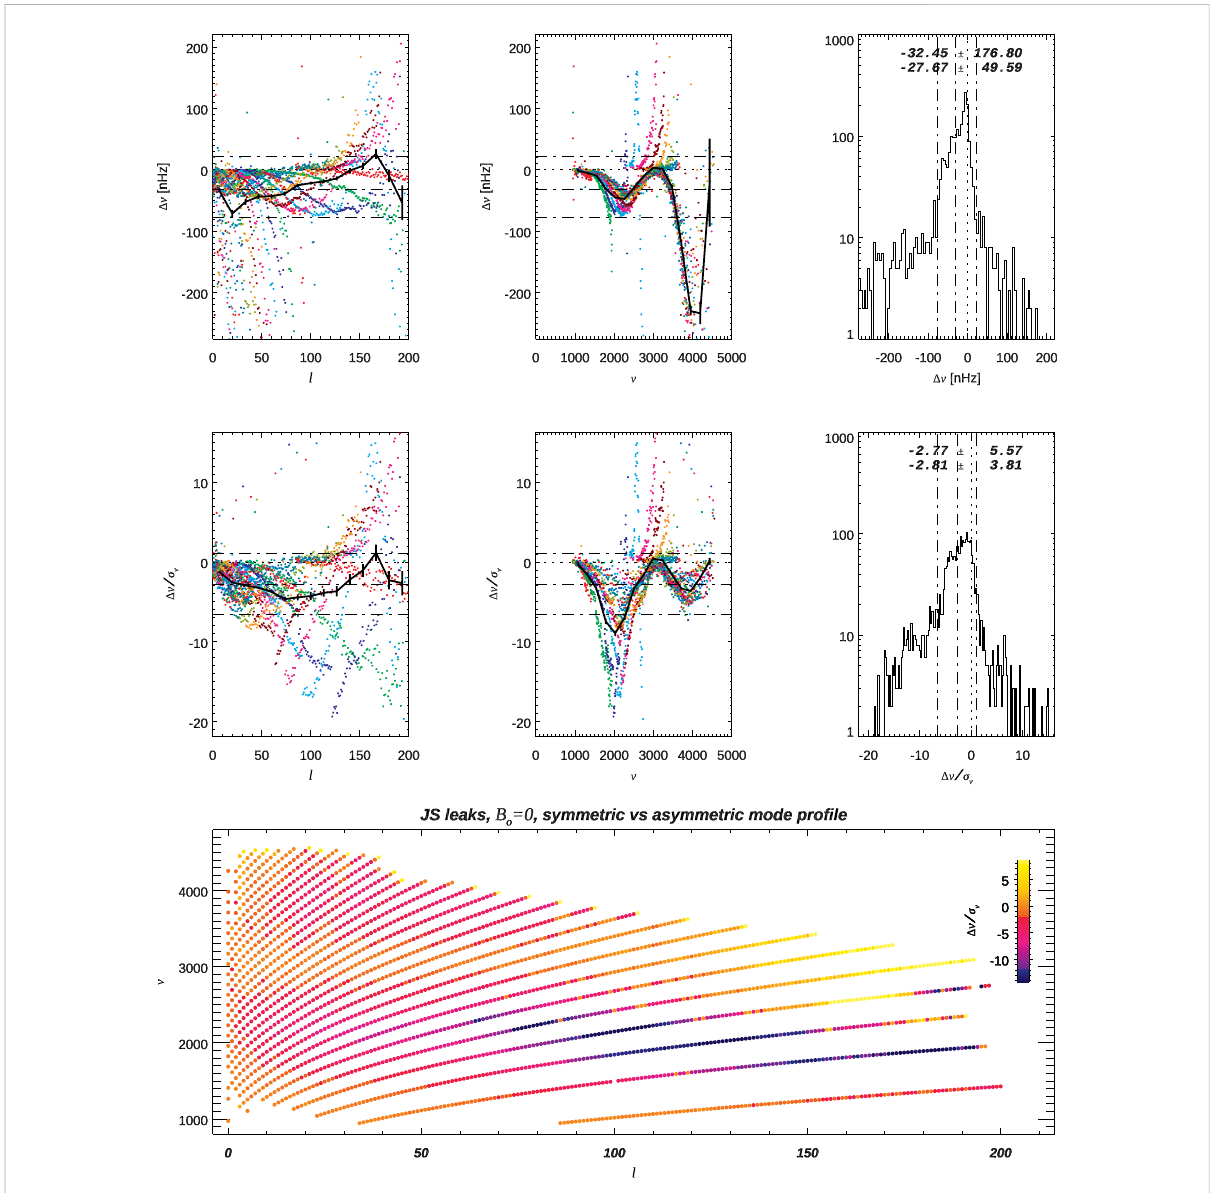
FIGURE 5 Comparison of multiplets ’ frequencies when fi tting symmetric or asymmetric mode pro fi les using the same leakage